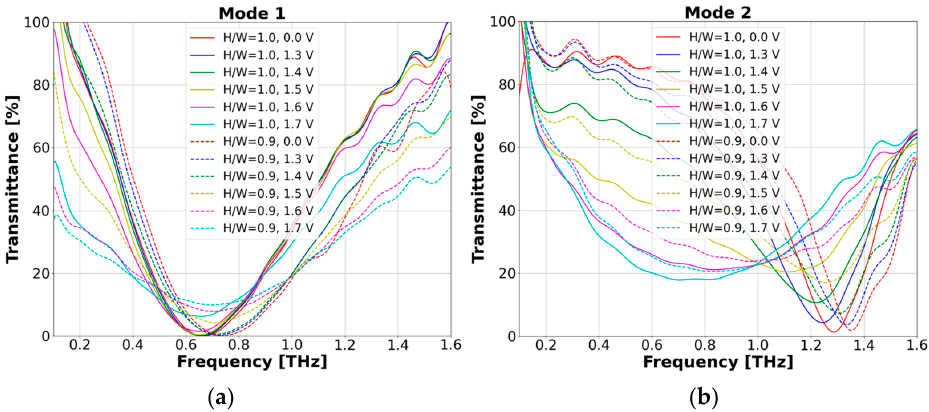
Figure 8. THz transmittance of the two metamaterials with different aspect ratios depending on the voltage applied to the heater in ( a ) mode 1 and ( b ) mode 2.